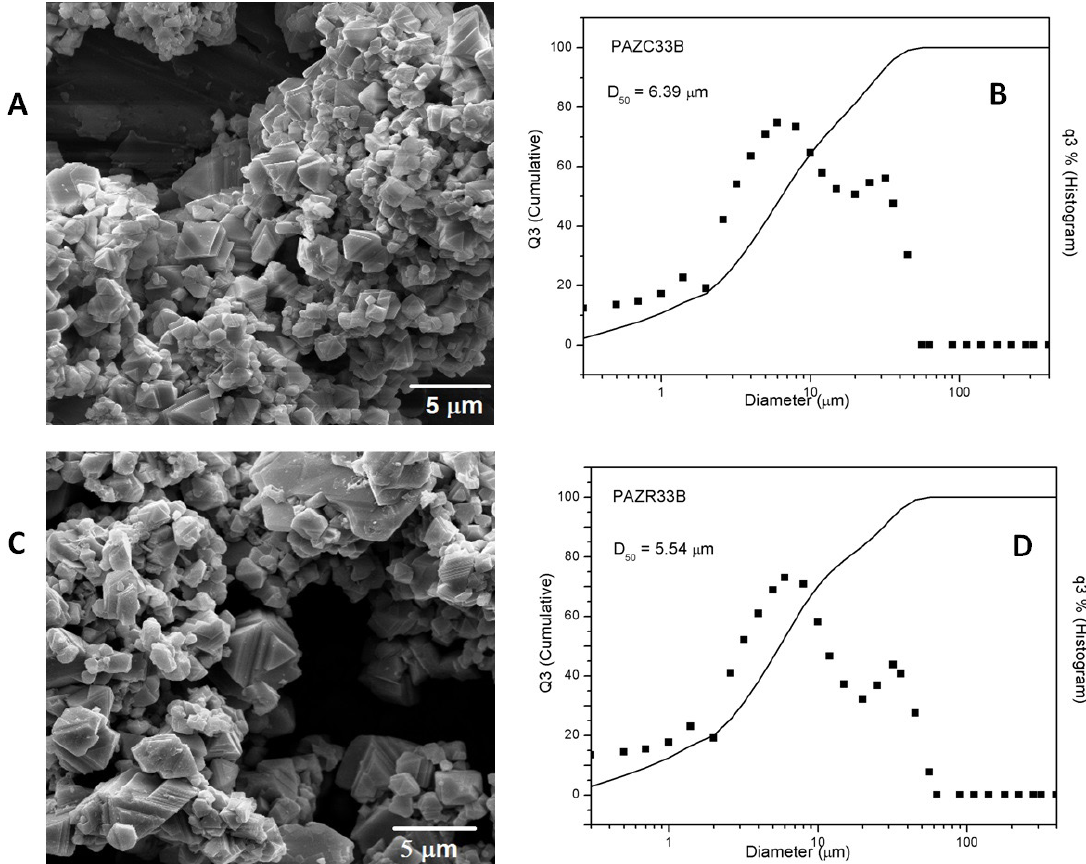
a sample, after heat treatment at 1200 °C. The a, b, a